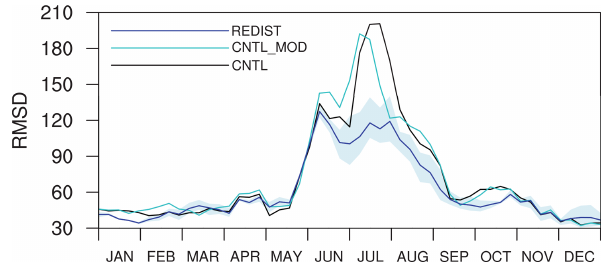
Figure 4. Time series of the 3-week moving average of RMSD of surface CO 2 flux (gCm − 2 yr − 1 ) for the CNTL (black solid line), CNTL_MOD (cyan solid line), and REDIST (blue solid line) exper- iments. The blue shaded band denotes the minimum and maximum RMSD across three random redistribution experiments.